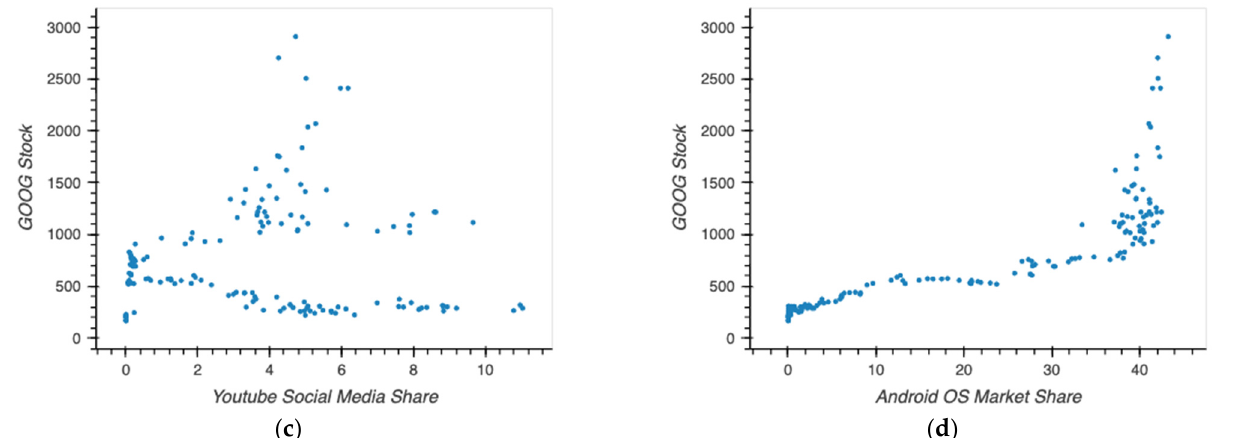
Figure 5. Correlation of Google’s market capitalization to its products: ( a ) Android OS market share; ( b ) Chrome browser market share; ( c ) YouTube social media share; ( d ) Google search engine share.